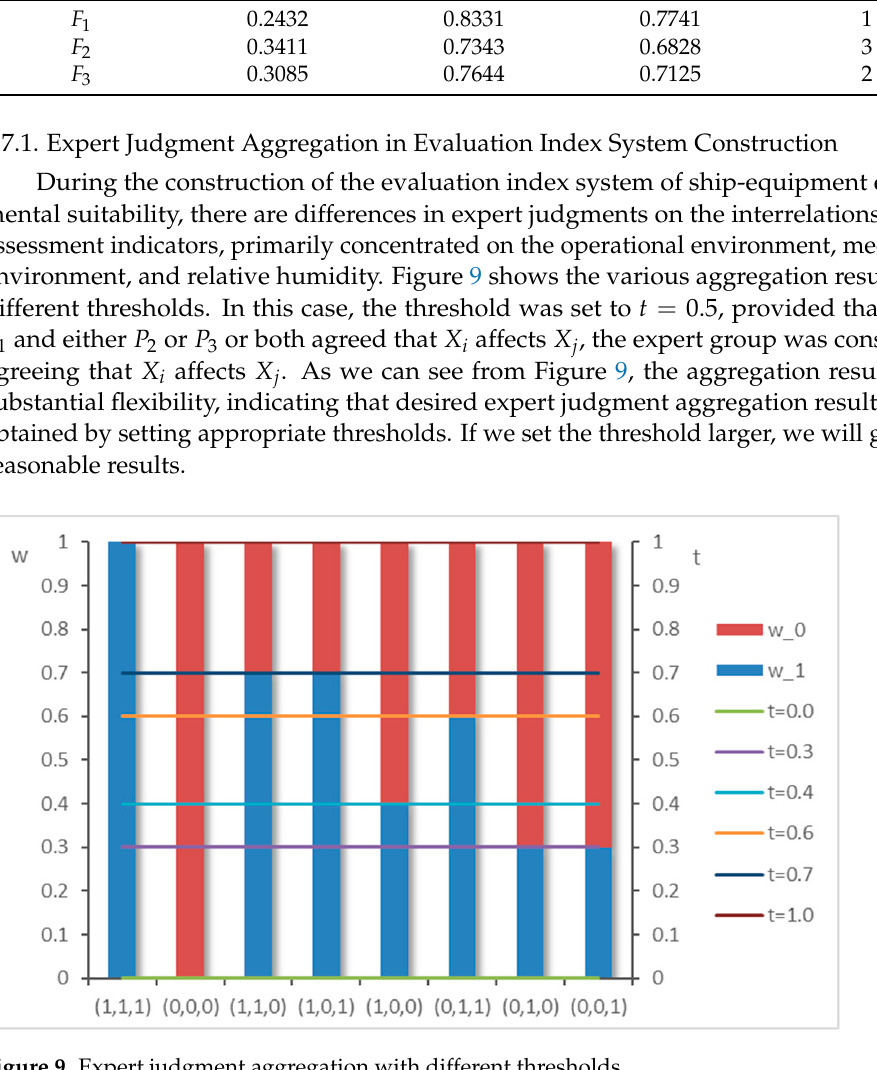
Figure 9. Expert judgment aggregation with di ff erent thresholds.